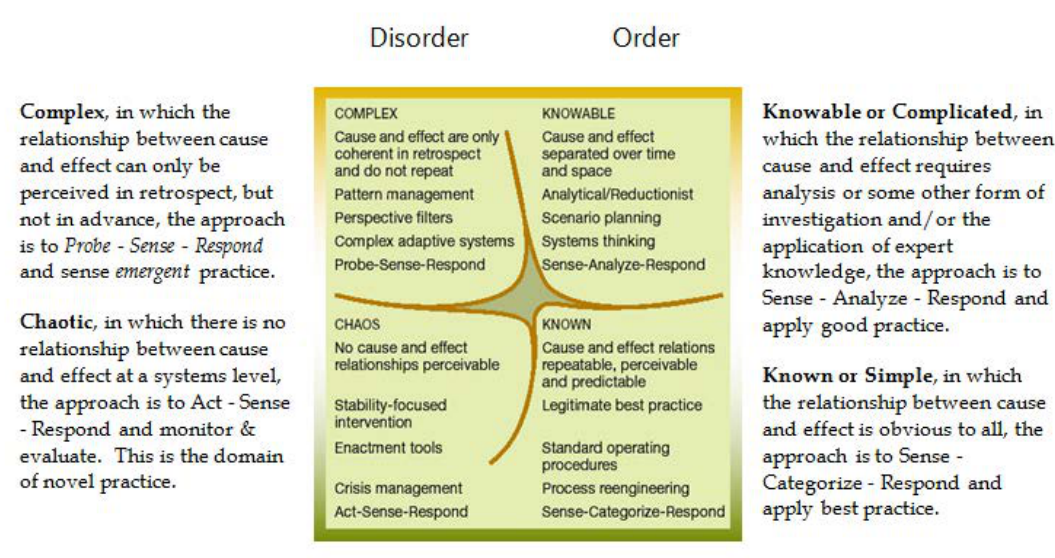
Figure ii: the Cynefin Framework, accessed May, 2013 10 The Cynefin Framework was developed as an instrument to assist decision makers in defining the type of challenge they are facing and to guide their response to that challenge. The framework is divided into four principal domains into which different types of challenges may be positioned so that appropriate management responses can be applied, depending on the